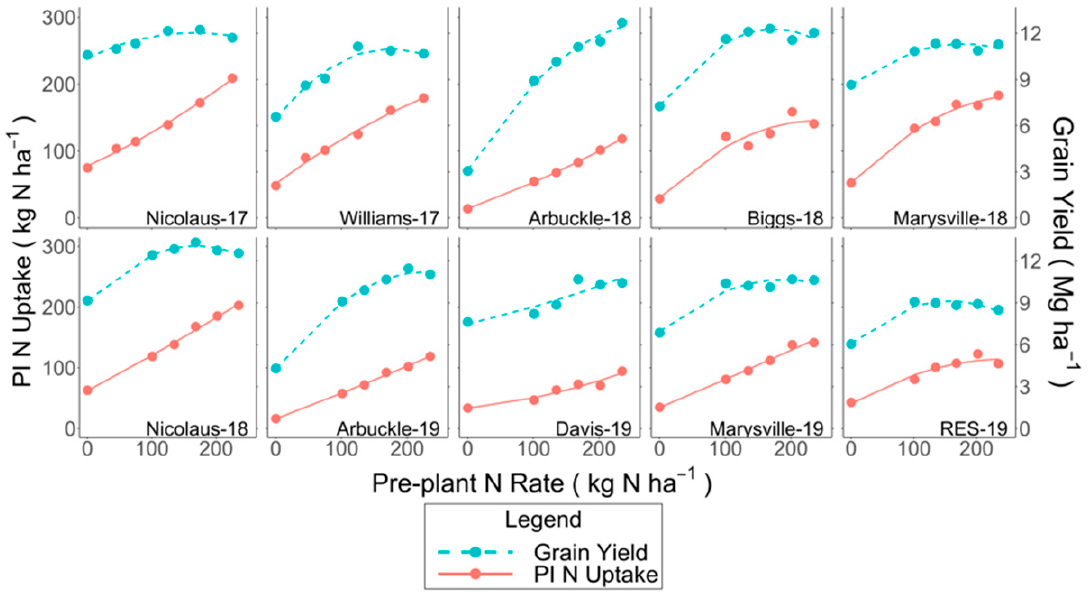
Figure 2. The relationship between pre-plant N rate and panicle initiation N uptake (PI-N UP ) (left axis) and grain yield (right axis) as described by quadratic linear regression models.